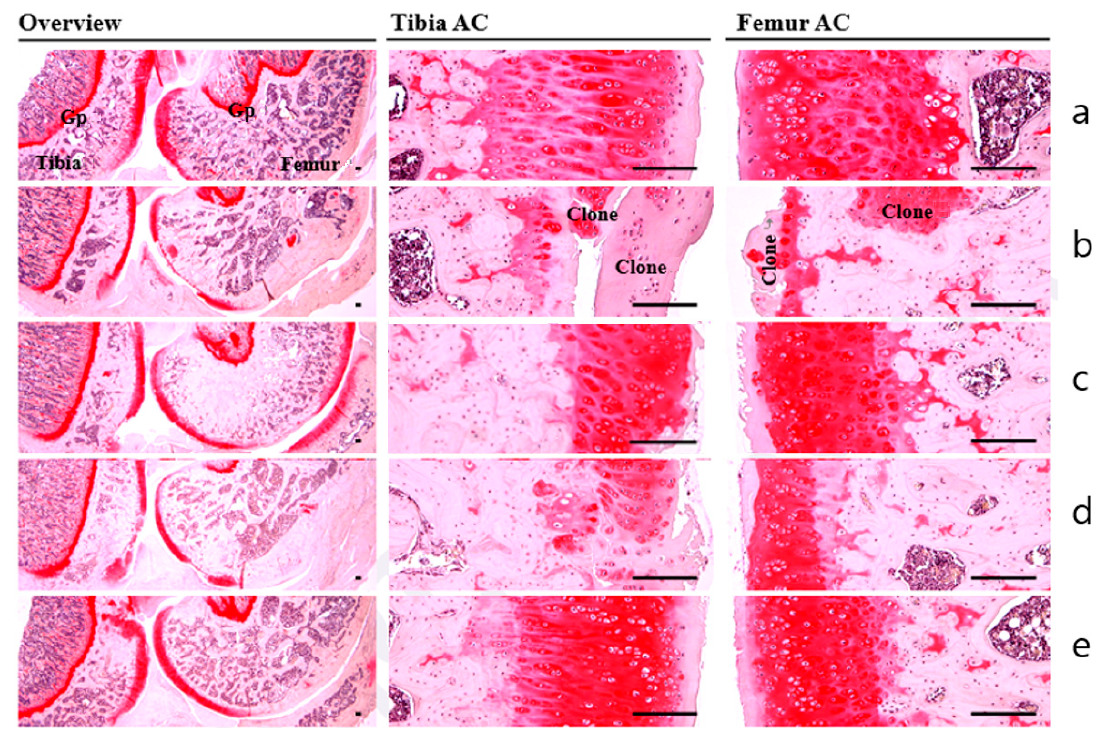
Figure 3. The effects of PS- on SO-stained histopathological characteristics of joints and synovial